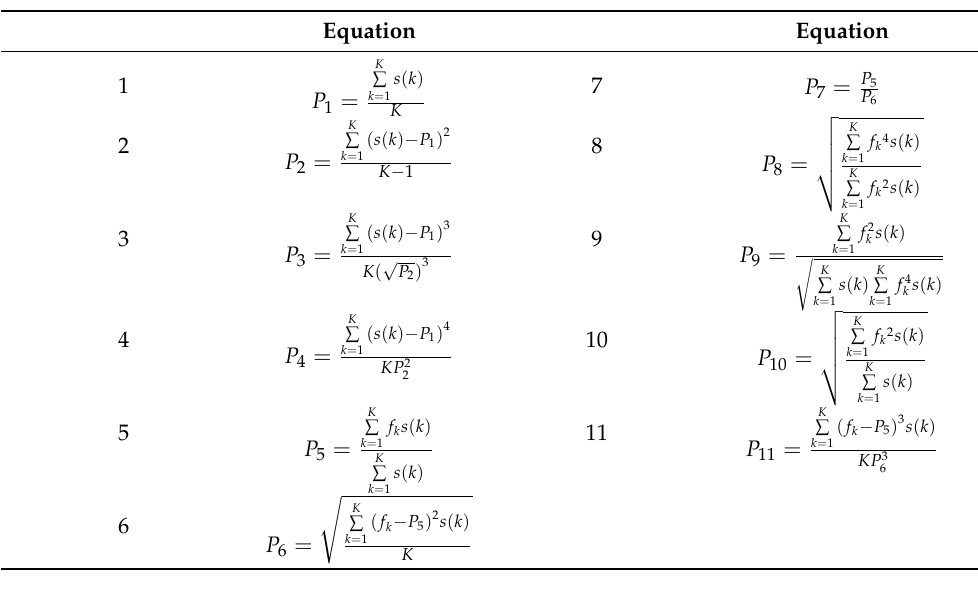
Table 2. The characteristic parameters in frequency